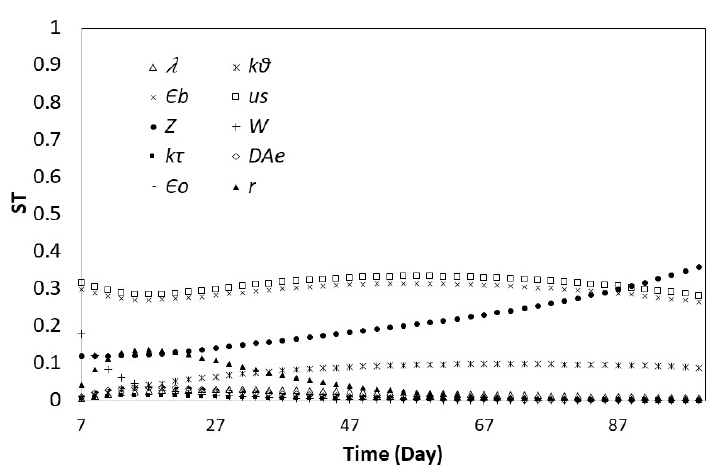
Figure 14. GSA of the model at (cid:2013) (cid:3042) 0.06.